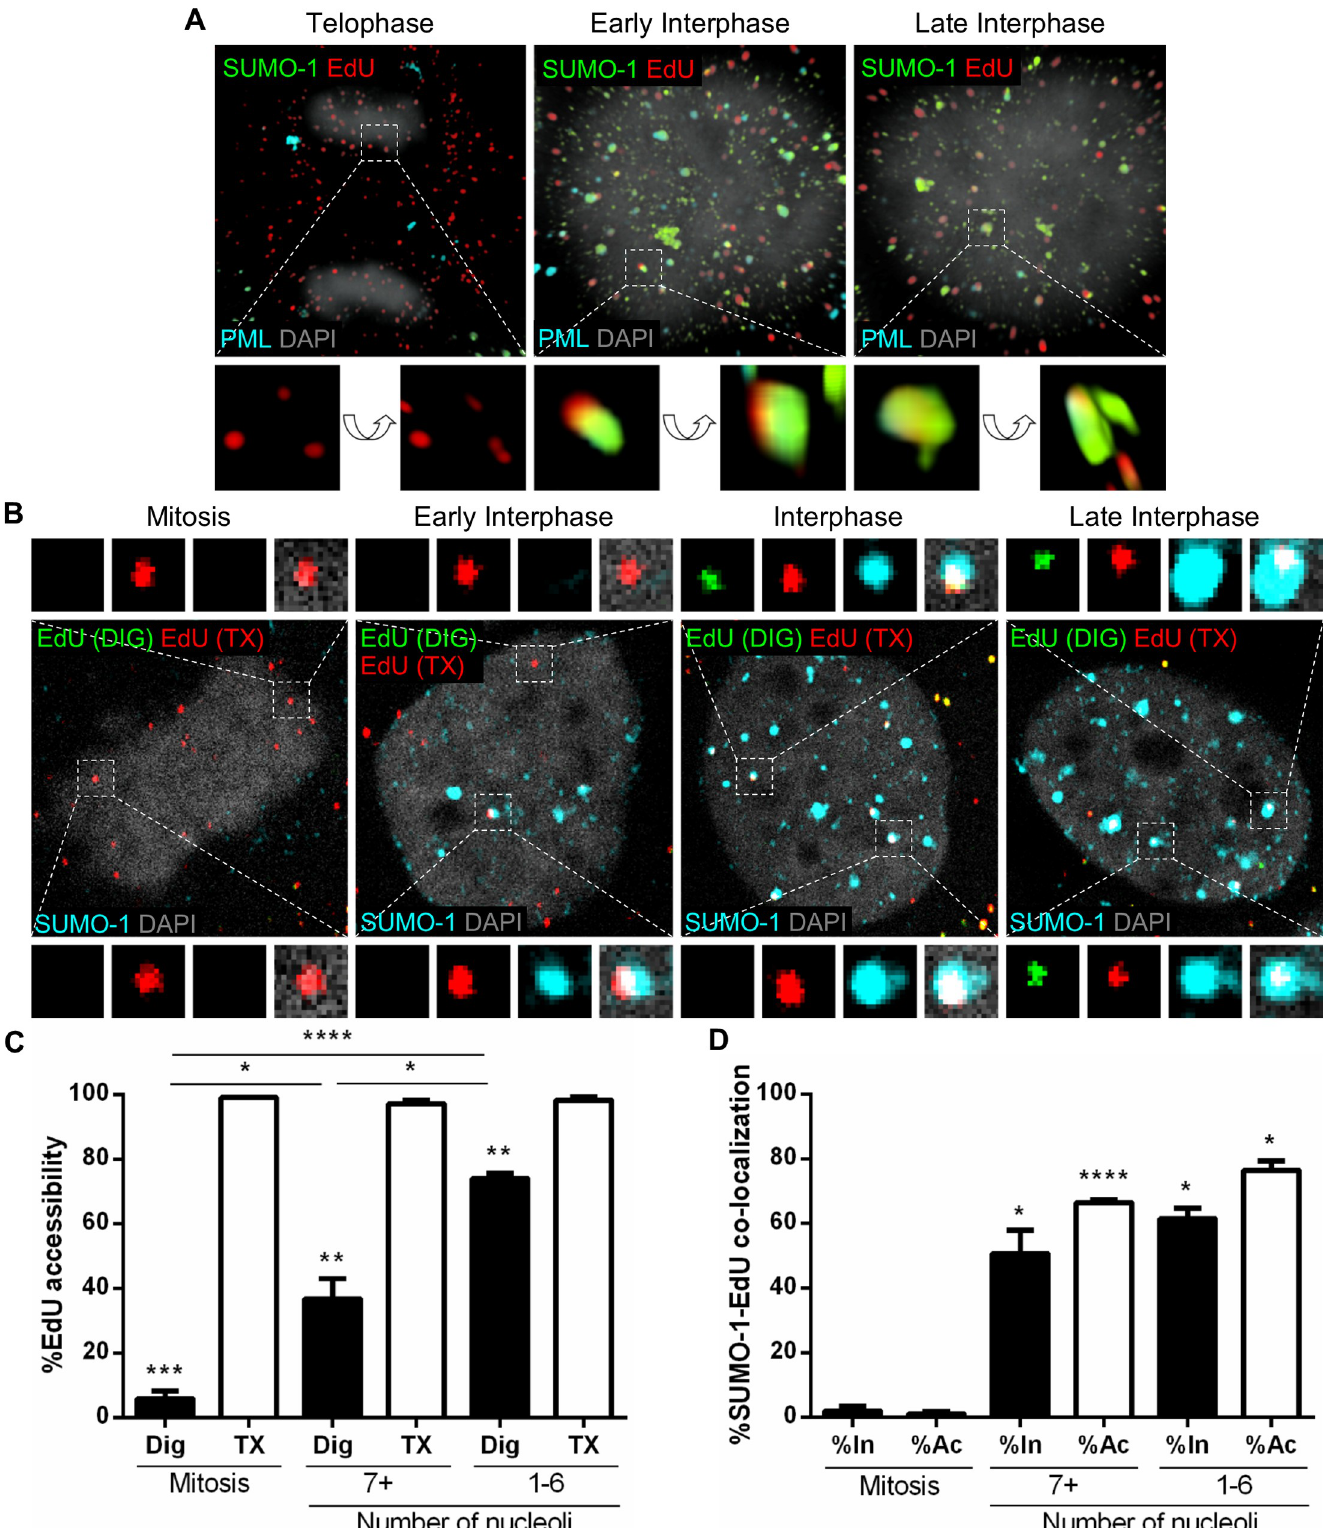
Fig 4. Viral genome associates with SUMO-1 while still inaccessible to small molecular dyes. (A) HaCaT cells were infected with EdU-labeled PsVs for 24 h, fixed, permeabilized, and treated with AF555 (red) in Click-iT reaction buffer. Next, cells were incubated with rabbit anti-SUMO-1 antibody (green) and mouse anti-PML